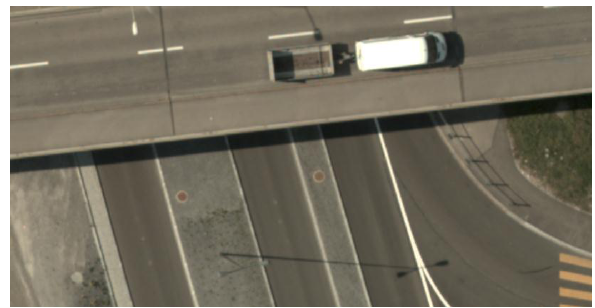
Figure 5. Extract from RCD30 RGB imagery showing the identical location as Figure 6 (mapping vehicle was driving in the middle lane with manholes visible on either side).